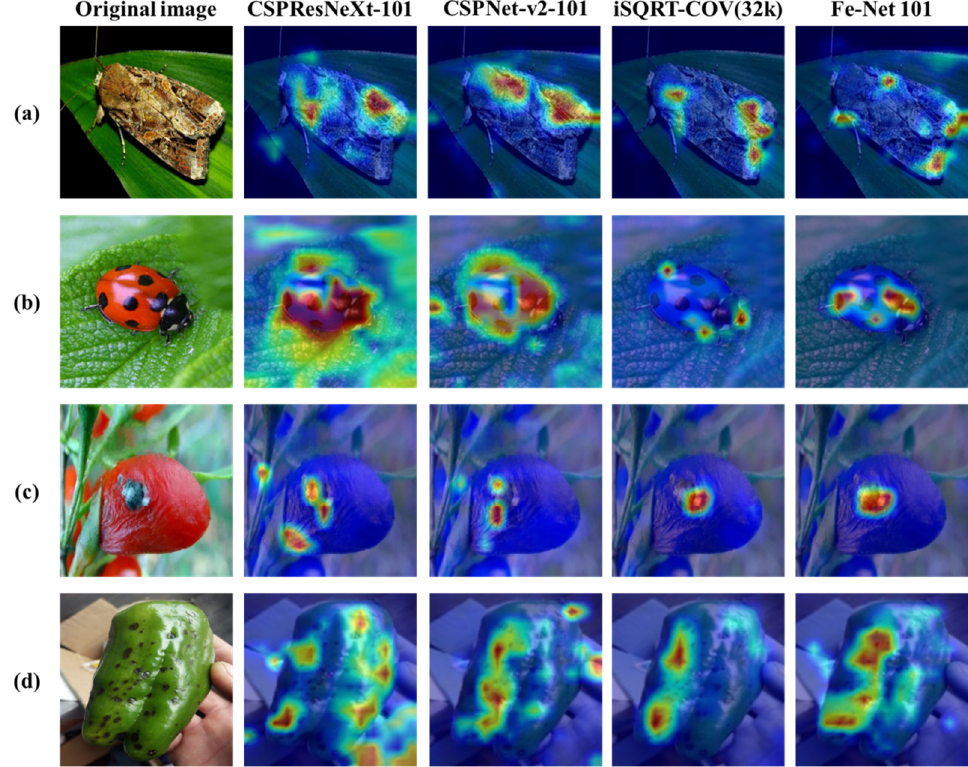
Figure 7. Characteristic thermograms of different methods: ( a ) Spodoptera frugiperda, ( b ) Coccinellidae, ( c ) Medlar anthracnose, and ( d ) Pepper scab.